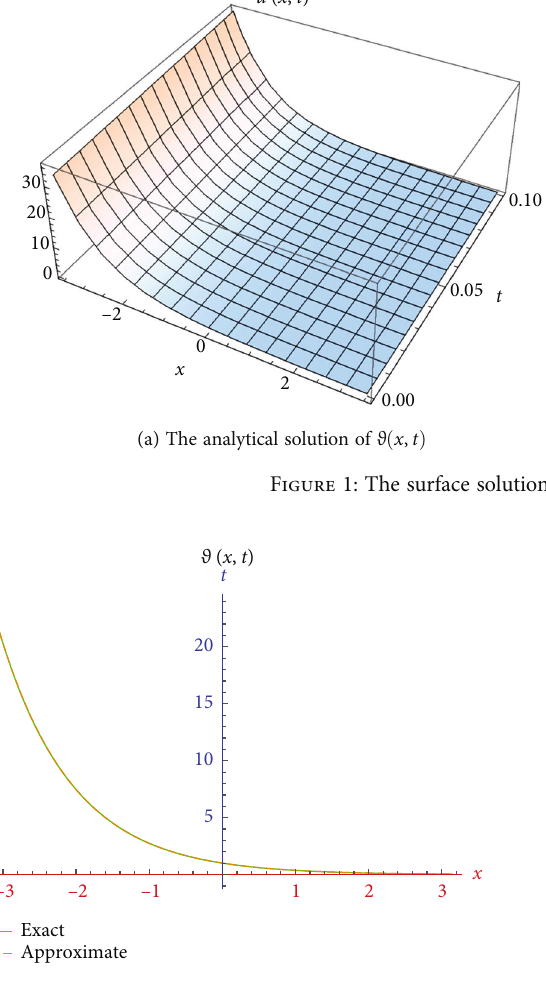
Figure 2: 2D plot for ϑ ð x , t Þ with various parameter of t